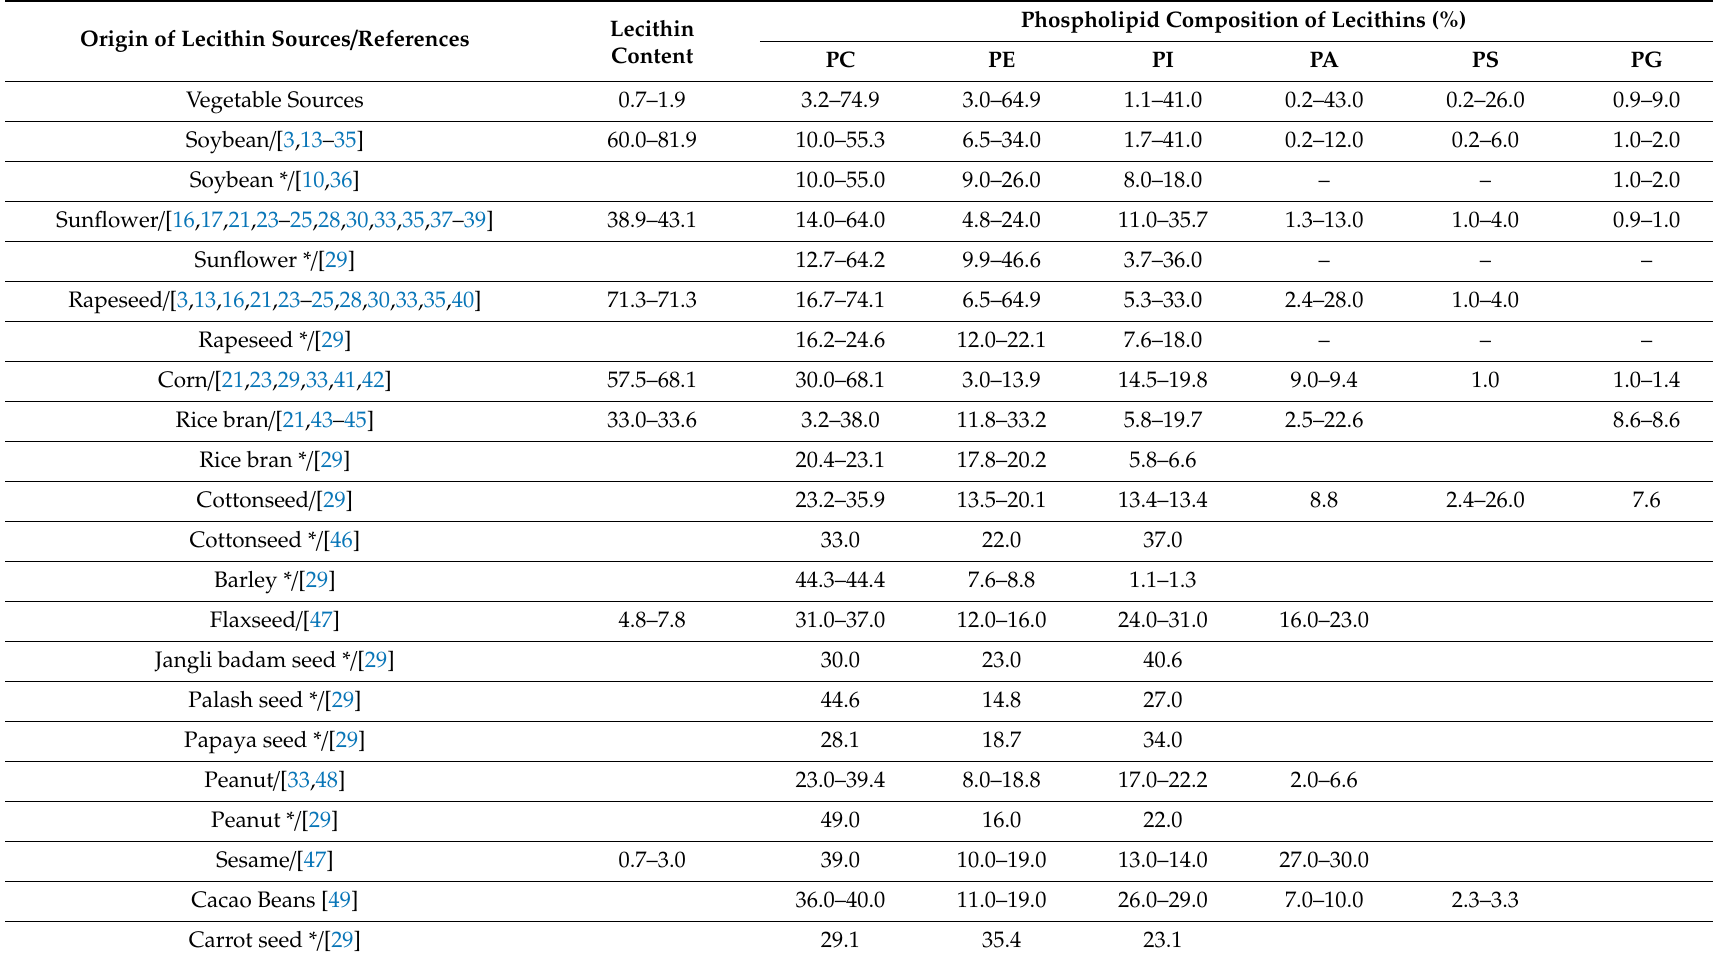
Table 1. The phospholipid composition of natural lecithins derived from vegetable